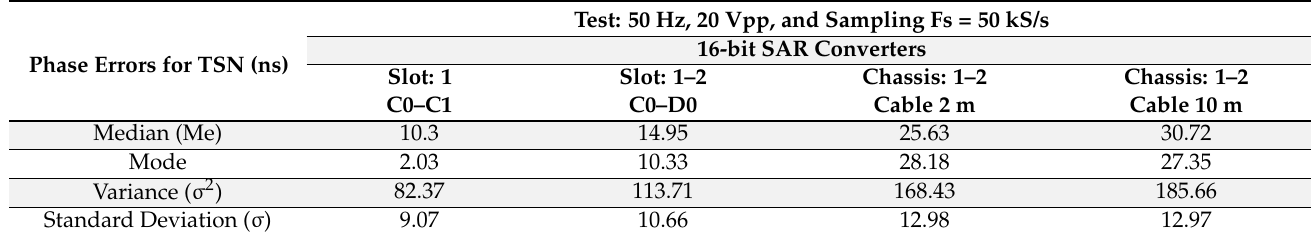
Table 4. Phase errors for SAR converters.